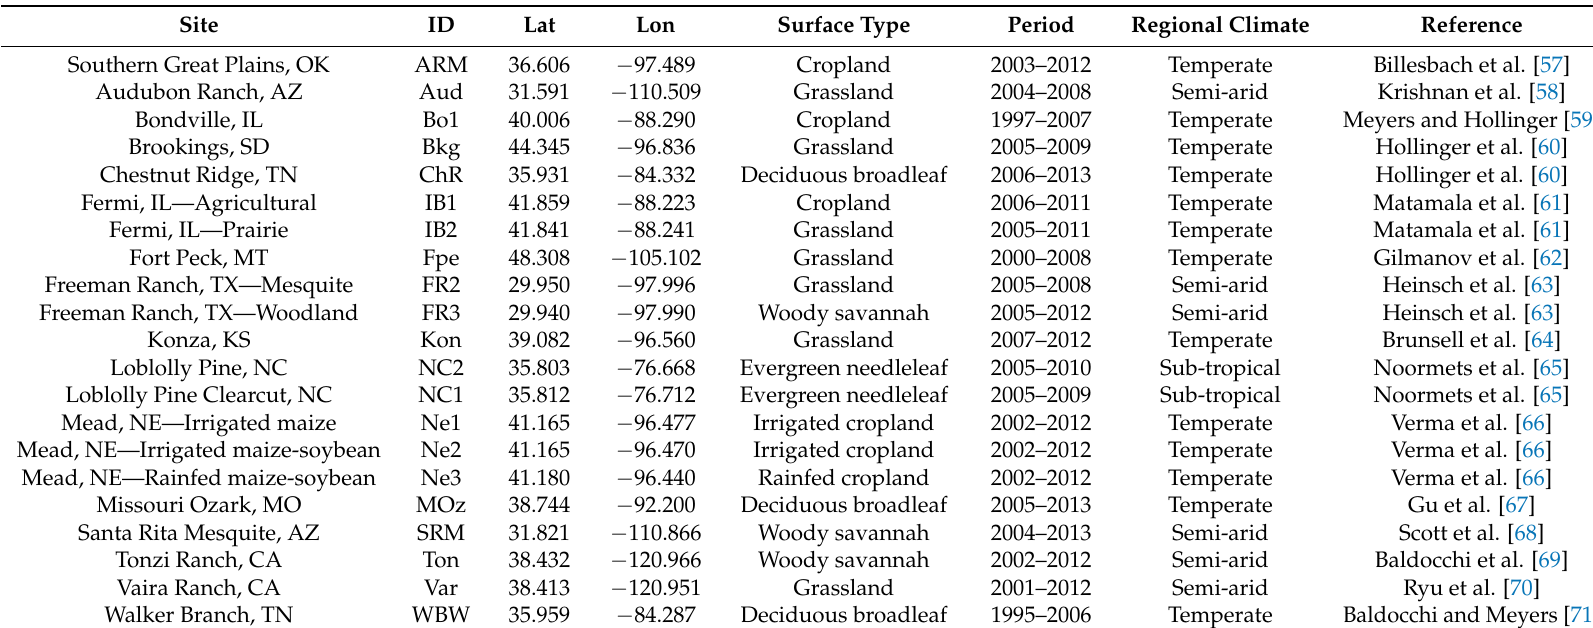
Table 2. List of AmeriFlux sites, including site geolocation, primary surface type and period of time considered for each dataset. Ameriflux data availability varies from site to